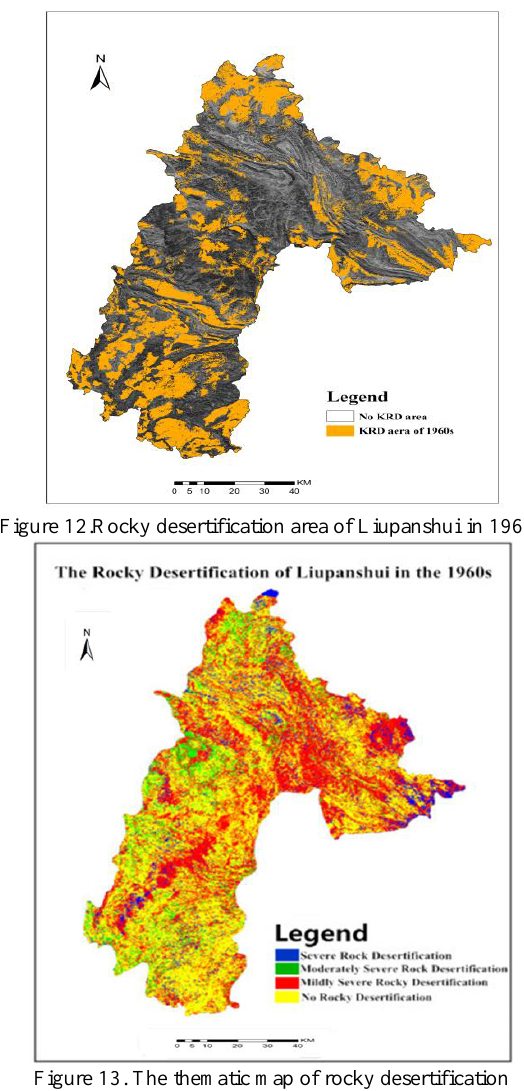
Figure 13. The thematic map of rocky desertification distribution in Liupanshui City in the 1960s (Yellow: no rocky desertification, Red: mildly severe, Green: moderately severe, Blue: